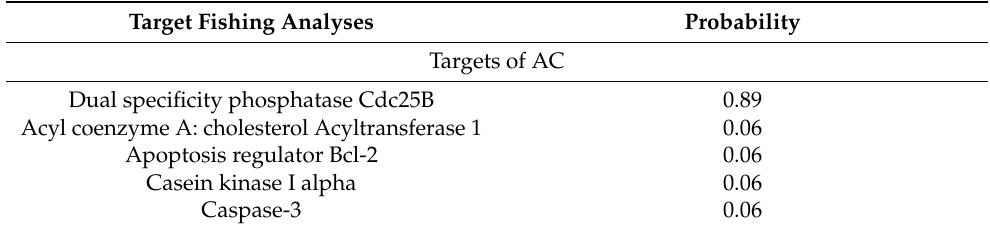
Table 4. Target fishing analyses for AC, BS-1 and ATD. The results show the top five targets of AC, BS-1 and ATD ranked according to their probability of being targets of each molecule. Probability values range from 0 to 1. Target fishing analyses were performed with Swiss Target